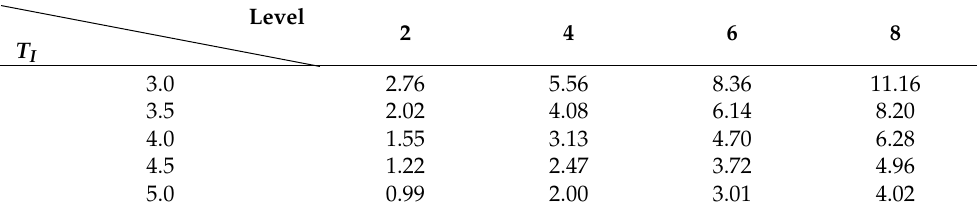
Table 3. Initial tension of the elastic element or cable that joins the isolator with the rack base, T 0 (kN). Level 2 T I